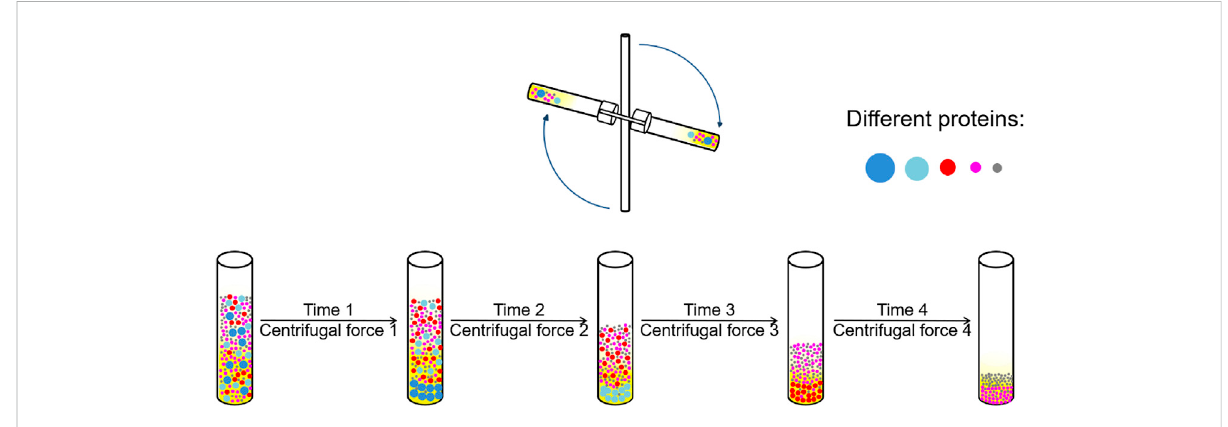
FIGURE 3 Differential centrifugation process. Different protein components were precipitated different centrifuge tubes with different centrifugal force and times.